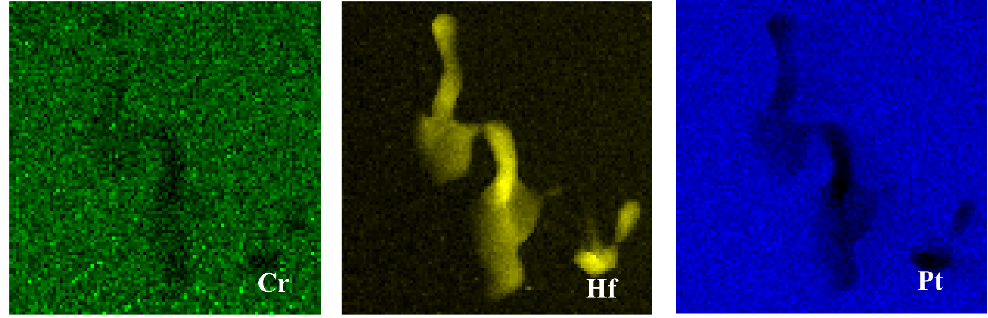
Figure 6. STEM HAADF image of the additive layer with corresponding maps presenting distribution of Al, Ni, Cr, Hf, Pt (Run I).